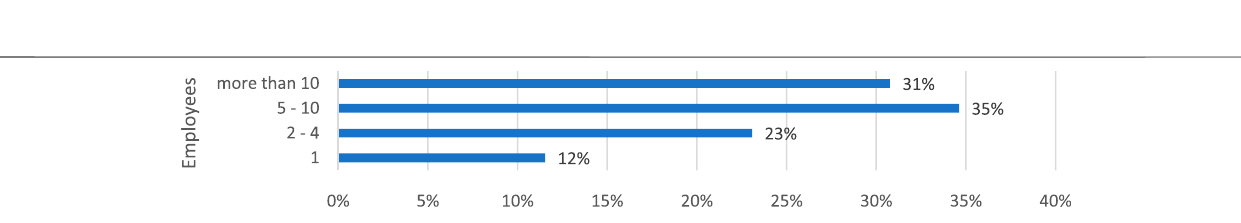
FIGURE 2 | Answers regarding the percentage of orders that logistics companies receive: automatically, into a standard format (doc, pdf, XML etc.) or in unstructured e-mails.